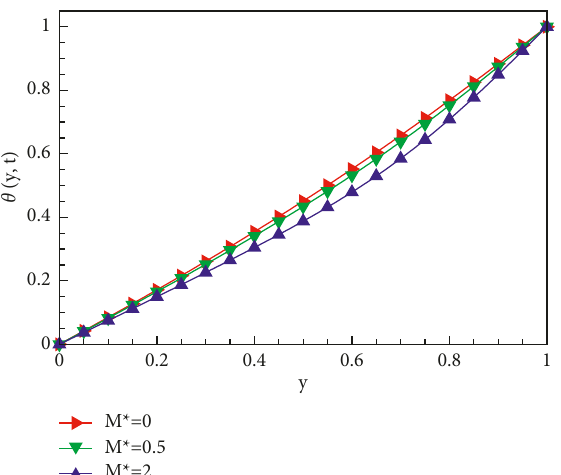
Figure 9: Influence of M ∗ on θ when α � β � 1 , λ α